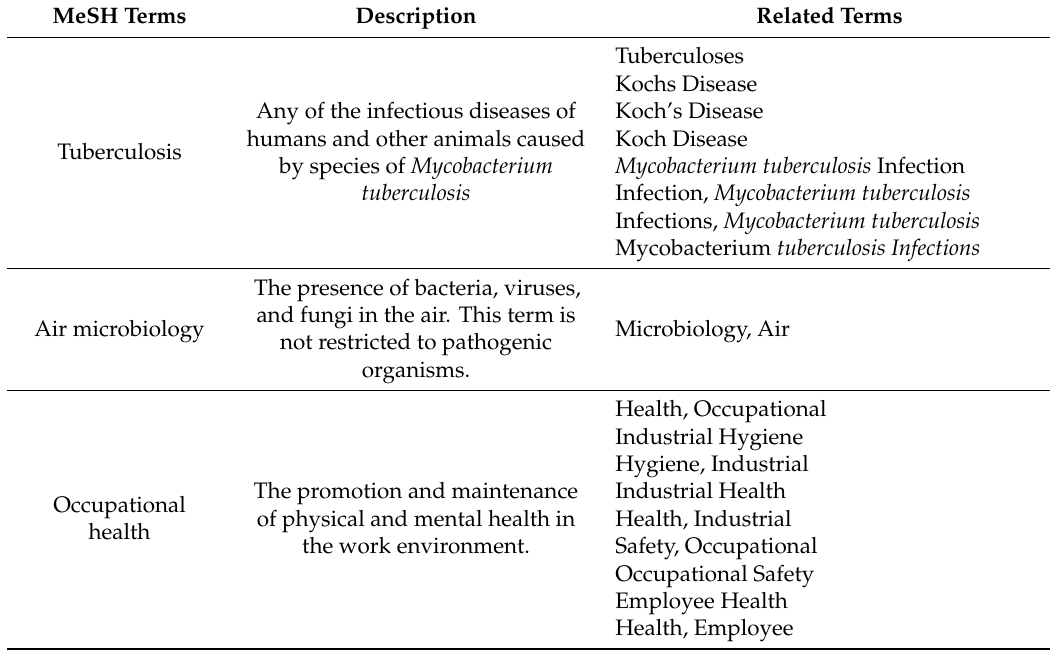
Table 2. MeSH terms and